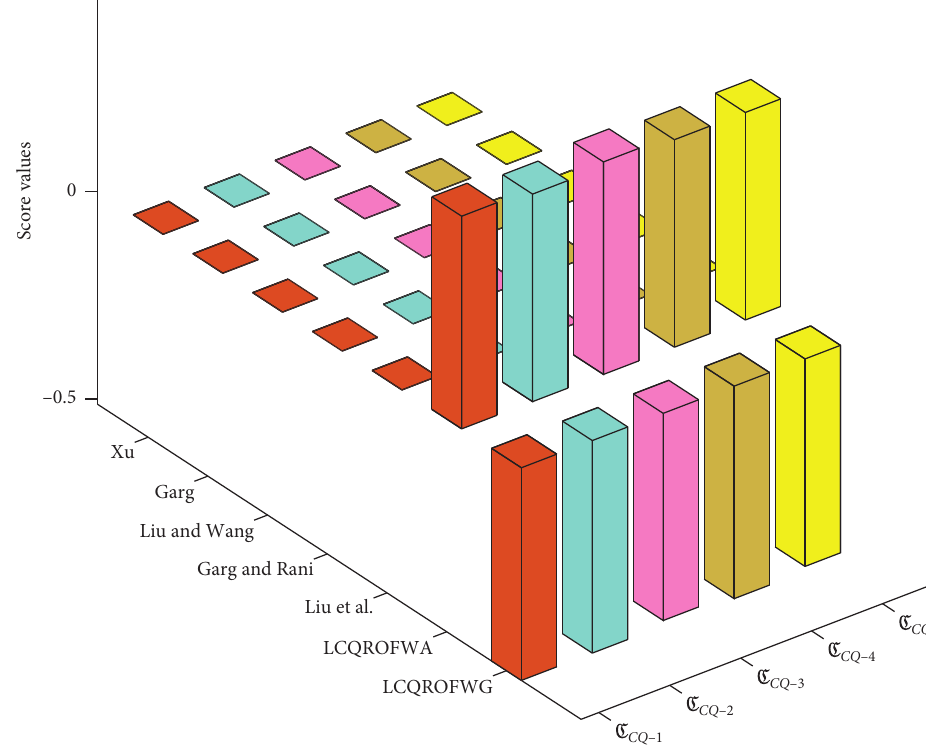
Figure 4: Graphical representations of the score values of the alternatives given in Table